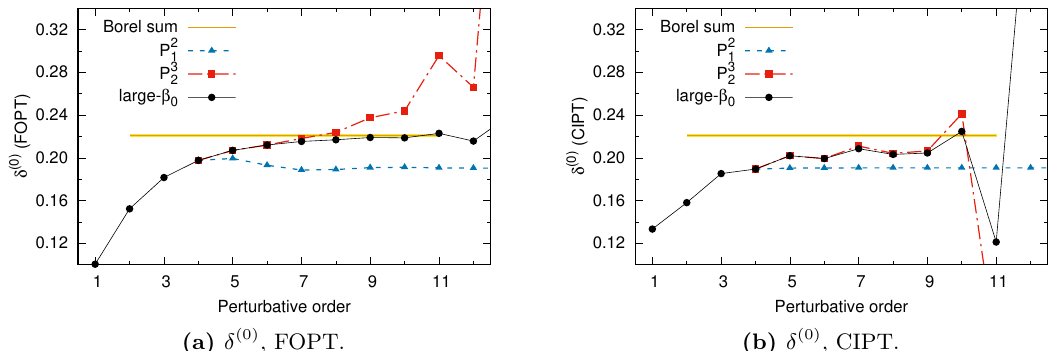
Figure 2. Results for (cid:14) (0) order by order in perturbation theory for large- (cid:12) 0 (solid line) and for the P 2 ( u ) (dashed line) and P 3 ( u ) (dot dashed line) in FOPT (left) and CIPT (right). The Borel 1 2 sum of series with its ambiguity is shown as the horizontal